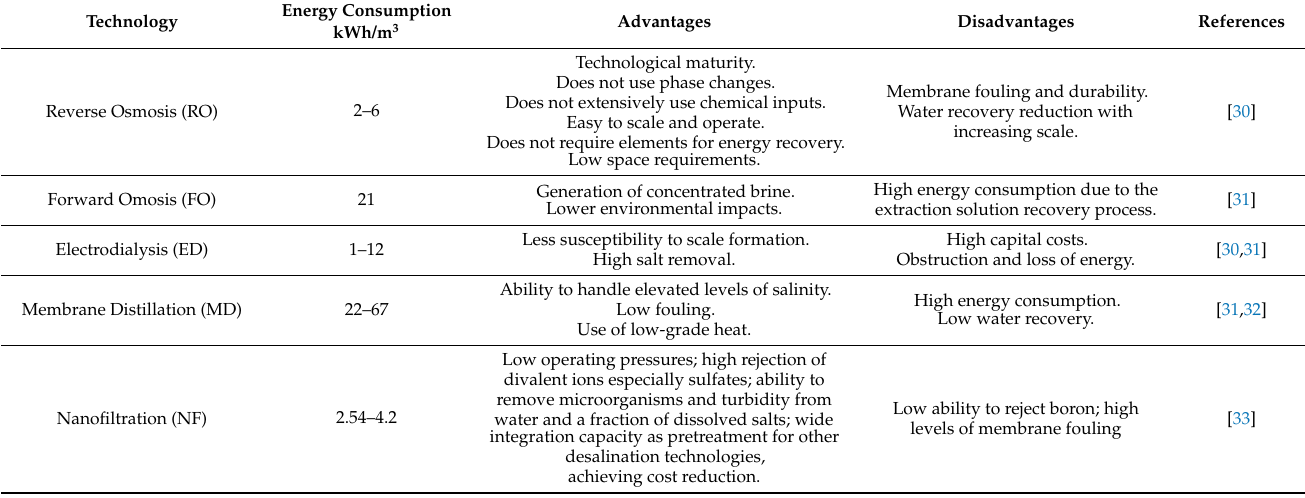
Table 2. Comparison of different membrane desalination